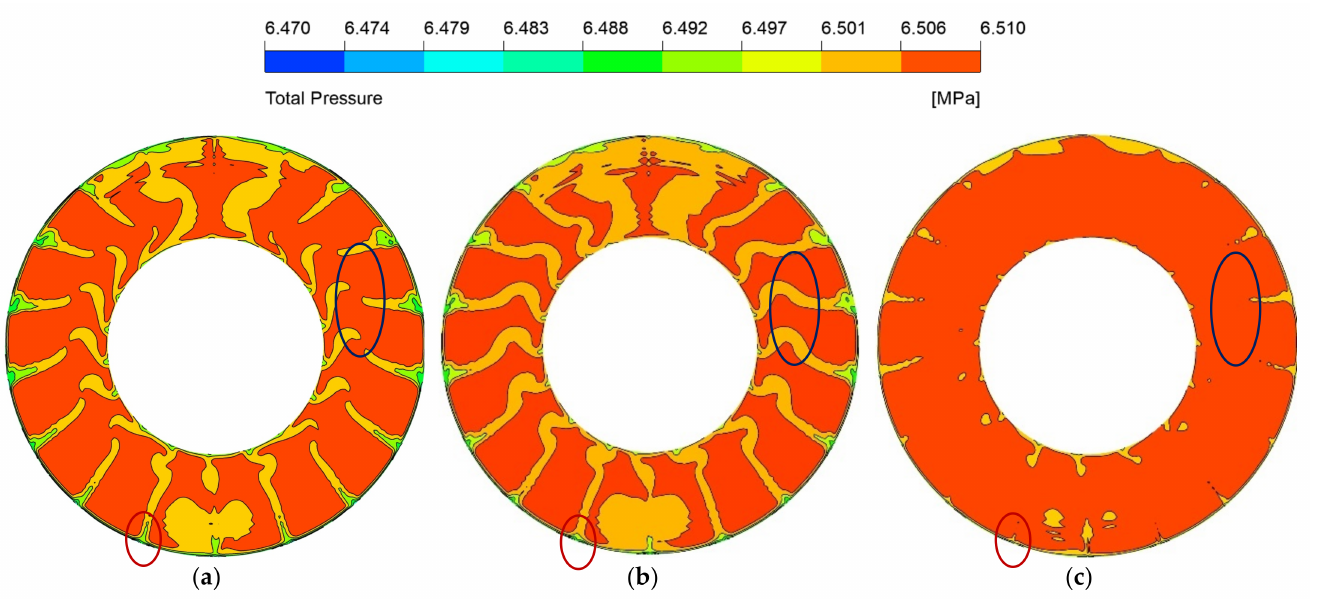
Figure 11. The total pressure comparison of ( a ) UGV, ( b ) SIS, and ( c ) TEB at cross-section 1-1.